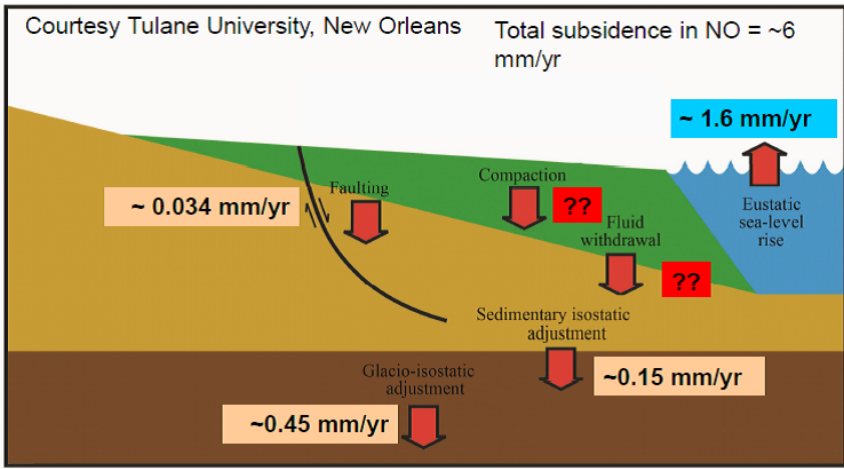
Figure 5. Subsidence components in the urban area of New Orleans. Values are derived from studies of Tulane University, New Orleans, and are indicative. The total subsidence rate is derived from InSAR measurements (Dixon et al., 2006). It shows that in the urban area natural subsidence forms the smaller portion of the total subsidence and that human induced subsidence